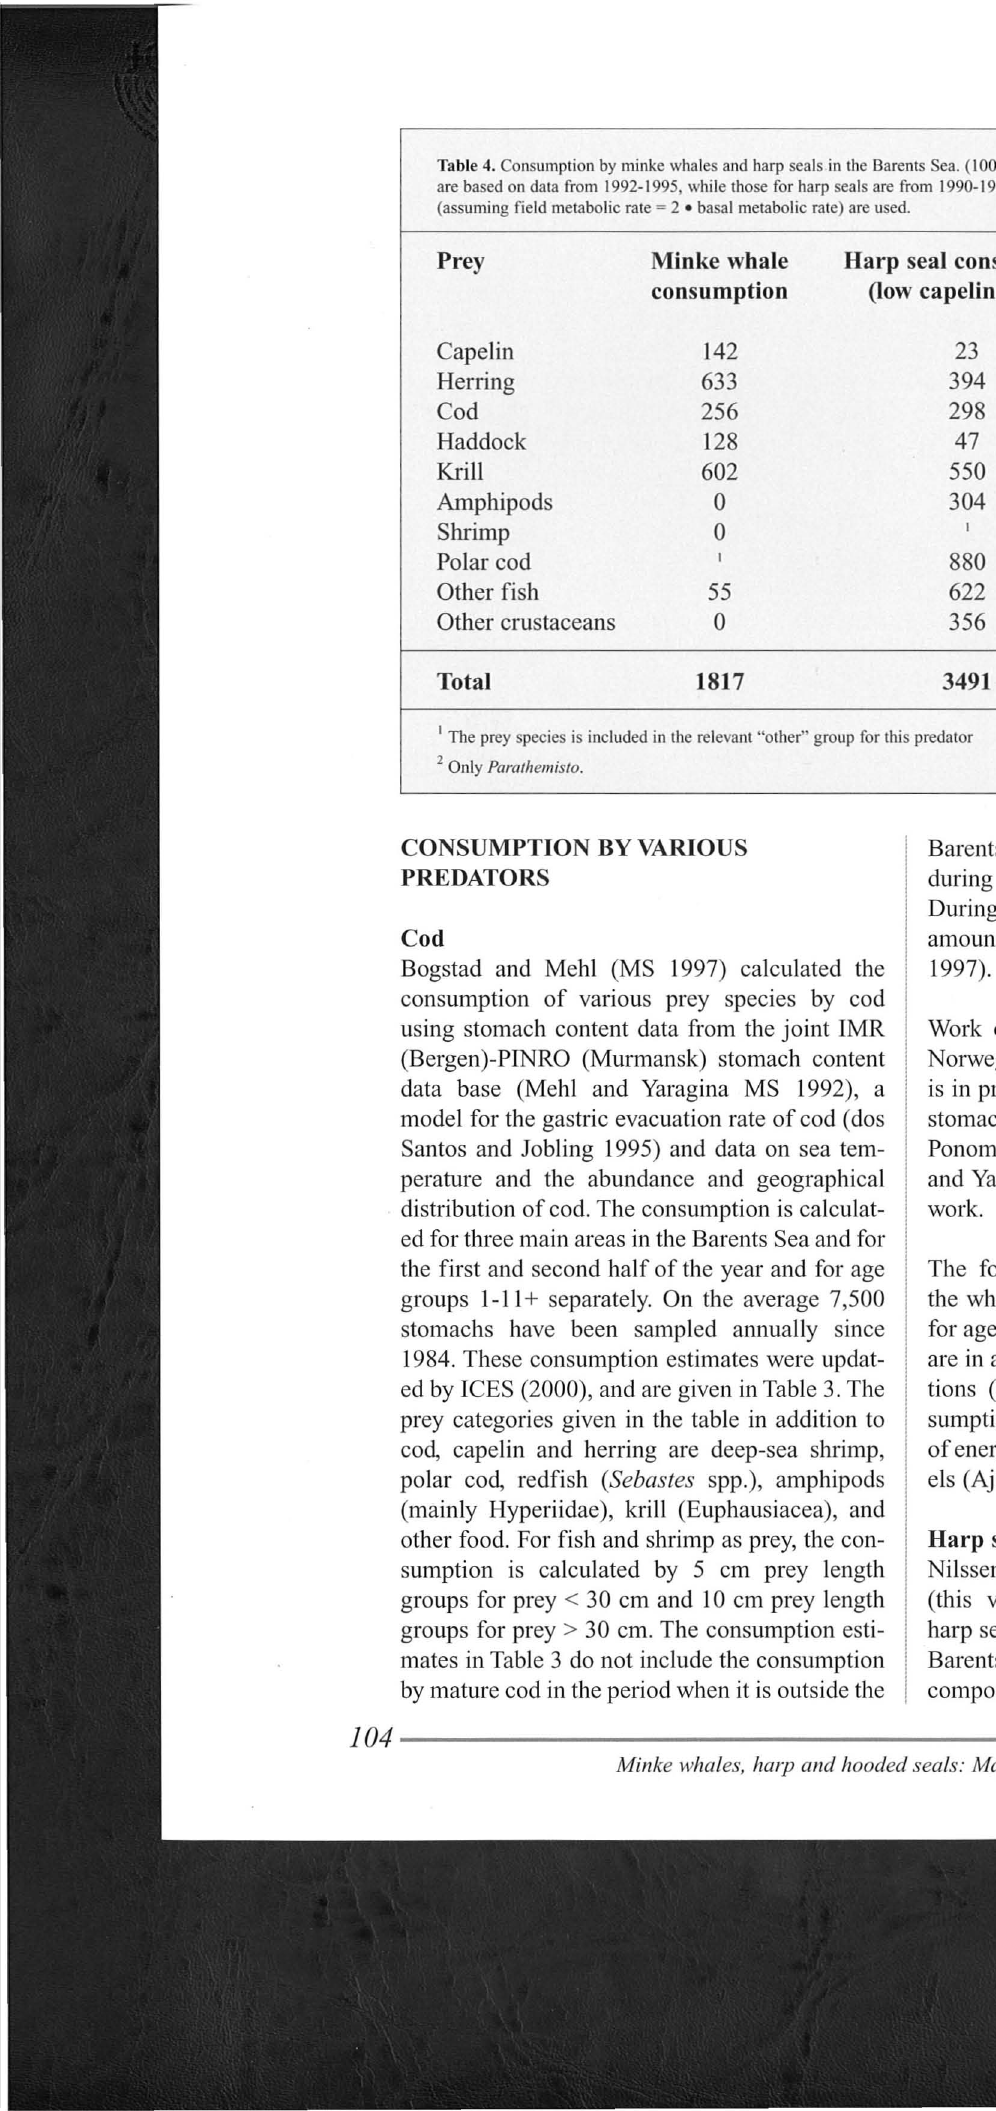
Table 4. Consumption by minke whales and harp seals in the Barents Sea. (1000's oftonnes, wet weight) The minke whale calculations are based on data from 1992-1995, while those for harp seals are from 1990-1996. For harp seals, the most conservative estimates (assuming field metabolic rate = 2 • basal metabolic rate) are